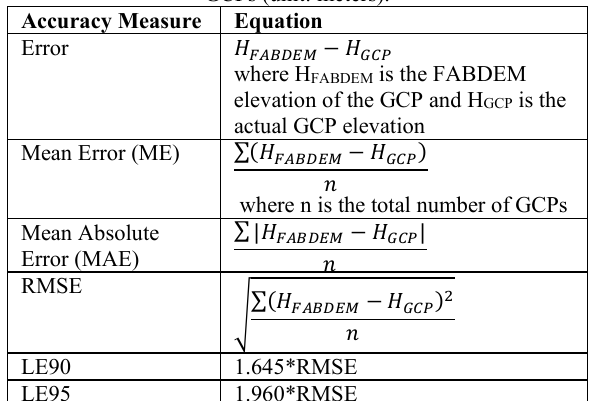
Table 3. List of equations used in the accuracy evaluation.